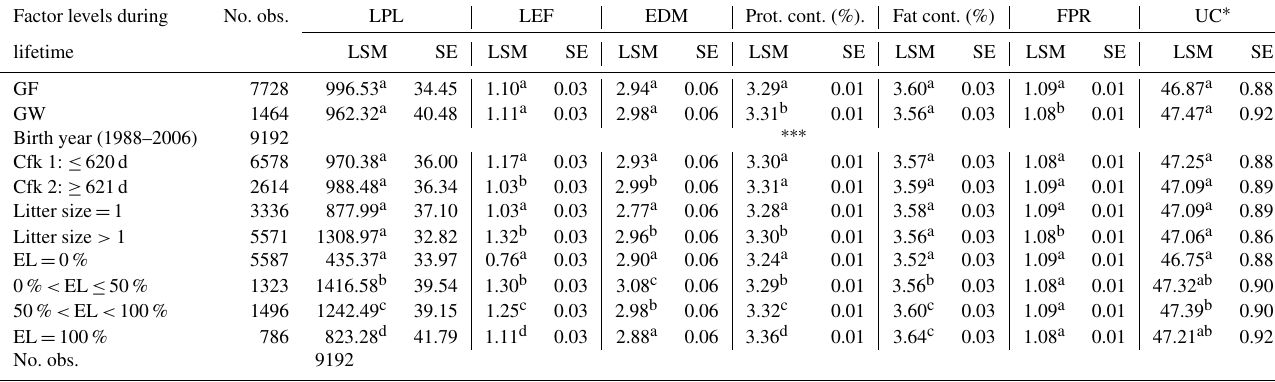
Table 4. LSM values during the dairy goats’ lifetime. Factor levels during No. obs. LPL LEF EDM Prot. cont. (%). Fat cont. (%) FPR UC ∗ lifetime LSM